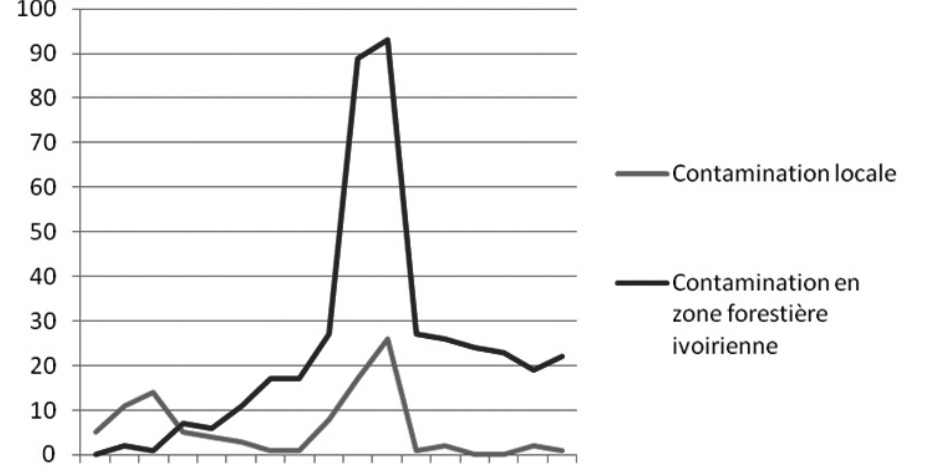
Figure 3. – Nombre de trypa- nosomés dépistés à Koudougou de 1971 à 1987 par zone pro- bable de